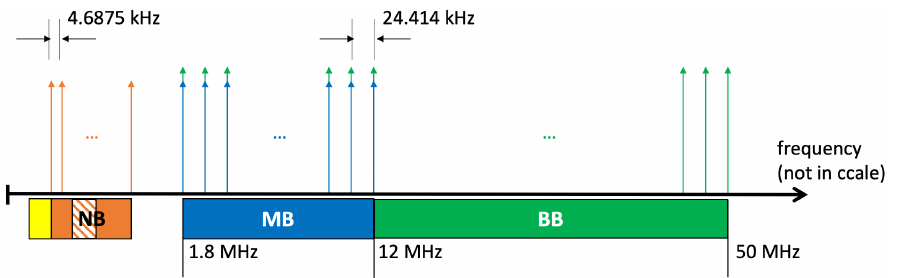
Figure A1. Frequency bands for the IEEE PLC standards and OFDM subcarriers separation. Notations NB, MB, and BB refer to narrow band, medium band, and broad band, respectively. Notice that the BB frequency range also includes the MB